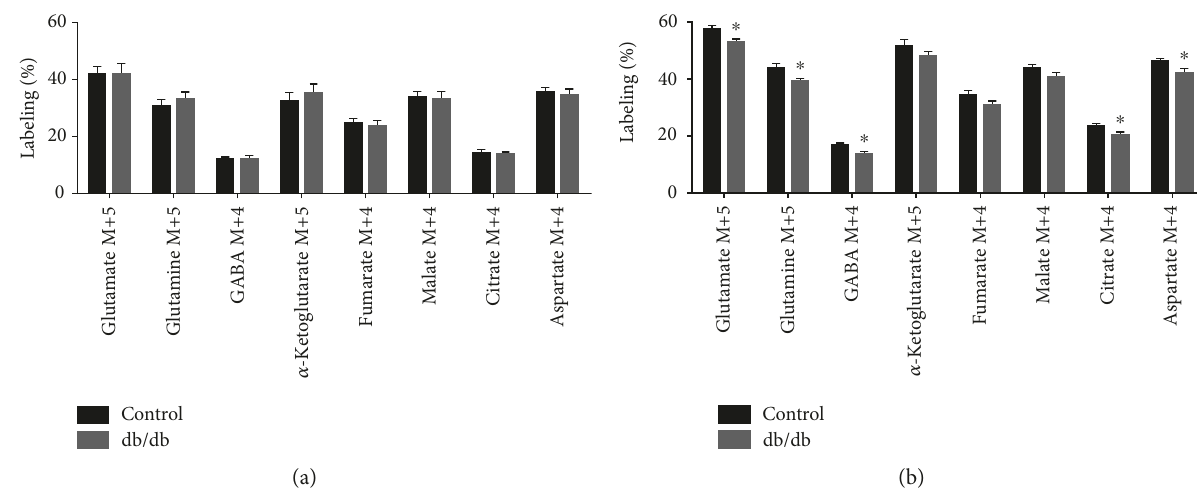
Figure 4: 13 C labeling from [U- 13 C]glutamate metabolism of cerebral cortical and hippocampal slices of control and db/db mice. TCA cycle intermediates and amino acids labeled from [U- 13 C]glutamate metabolism during incubations of cerebral cortical (a) and hippocampal (b) slices of control and db/db mice. Results are presented as means ± SEM, n = 8 – 11 , Student ’ s t -test, ∗ p < 0 05 .